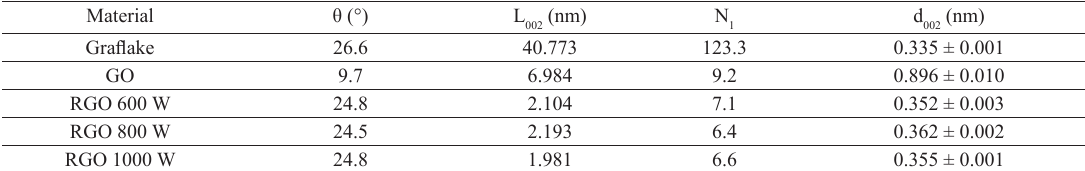
) and the number of layers (N). 002